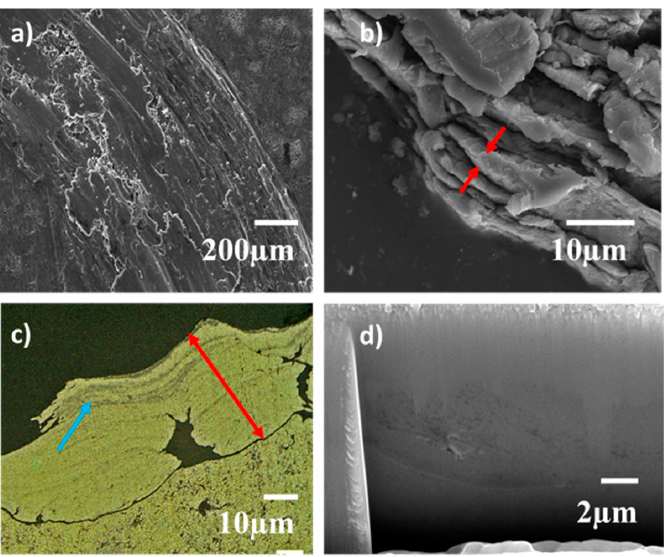
Figure 11. SEM micrographs of the Al- 2 vol %GNP sample (200 °C), showing ( a ) wear track and ( b ) wear debris, ( c ) Optical micrograph of the sub-surface of the wear track, ( d ) FIB image of the sub-surface of the wear track.